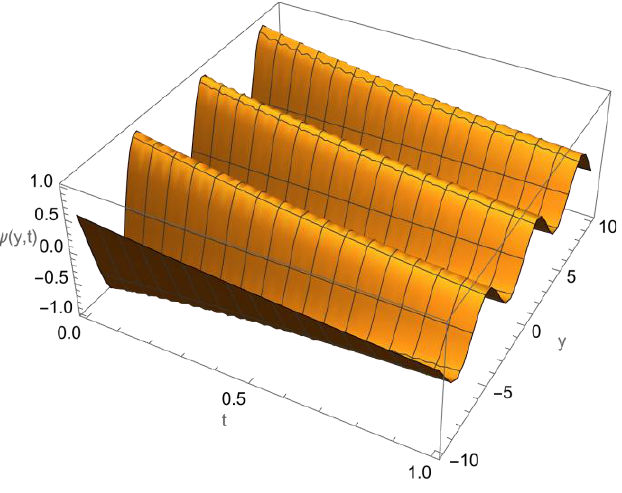
Figure 1. Exact solution 𝜓(𝑦, 𝑡) of Example 1.